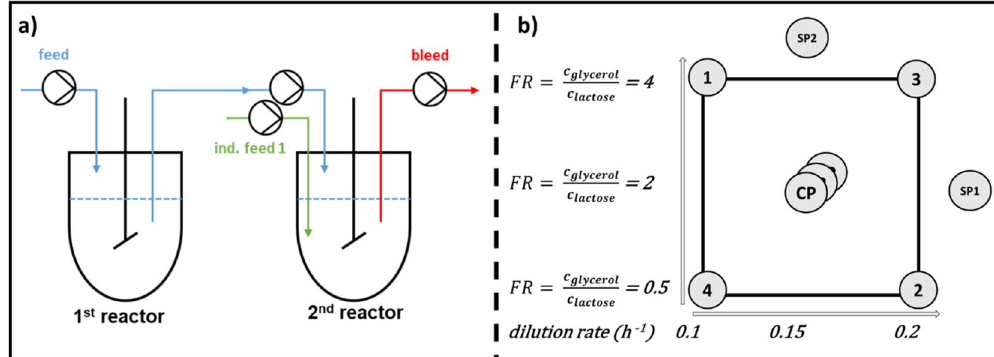
Figure 1. ( a ) Process overview of the cascaded continuous cultivation. Reactor 1 is used for biomass formation. Biomass stream is transferred to reactor 2, where recombinant protein production is induced; ( b ) showing the full factorial design of experiment (DoE) conducted for the factors dilution rate and feed ratio with the responses space–time yield and specific productivity, center point experiments were conducted in triplicates. (1–4 = run1– run 4, SP starpoint, FR feed ratio).